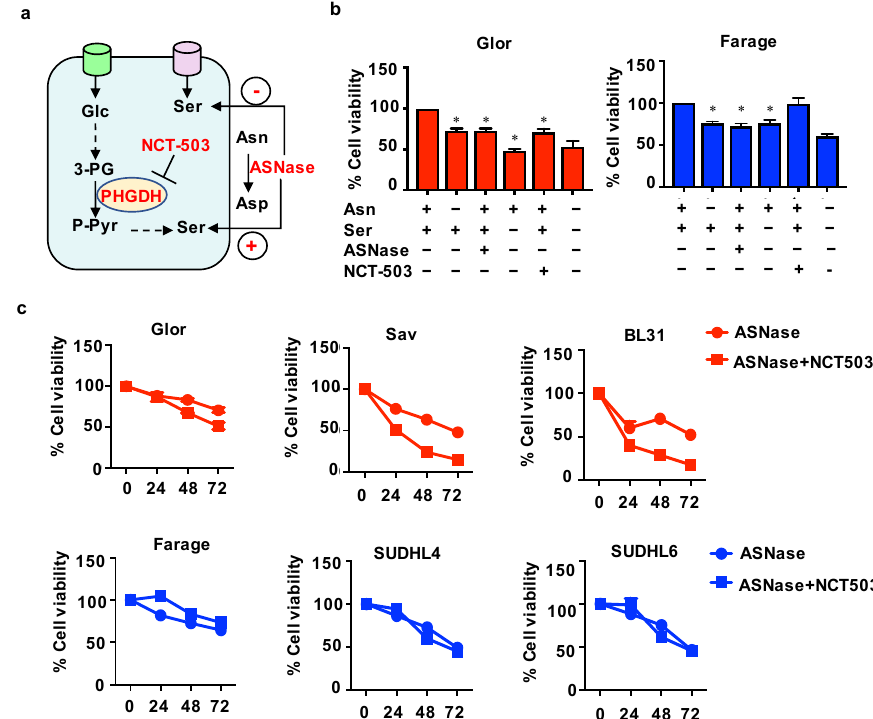
Figure 4. Combined effect of asparaginase and NCT503 on cell viability. ( a ) Illustration of combined effects of asparaginase (ASNase) and NCT503 on serine and asparagine metabolism. The viability of Glor and Farage cells in a complete medium, in asparagine-free medium, in serine free medium, in the medium with ASNase at 0.1 U/mL, in the medium with NCT503 at 10 μ M and in the serine and asparagine free medium after 72 h ( b ). Treatment of Glor, Sav, BL31, Farage, SUDHL4, SUDHL6 with ASNase at 0.1 U/mL and ASNase at 0.1 U/mL plus NCT-503 at 10 µ M for 24, 48 and 72 h ( c ). Cell viability was assessed by CellTiter Blue assay. Data is shown as mean ± SEM. * p < 0.05. Firstly, to gain insight into the effect of asparagine and serine on cell viability, BL